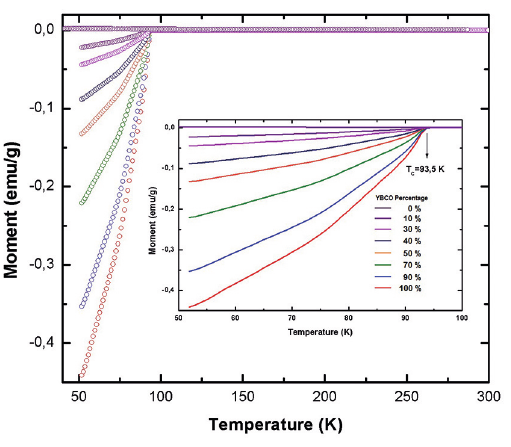
Figure 5: DC magnetic susceptibility for 100, 90, 70, 60, 50, 30, 10 and 0 mass% of SHNO in SHNO-YBCO polycrystalline composites.